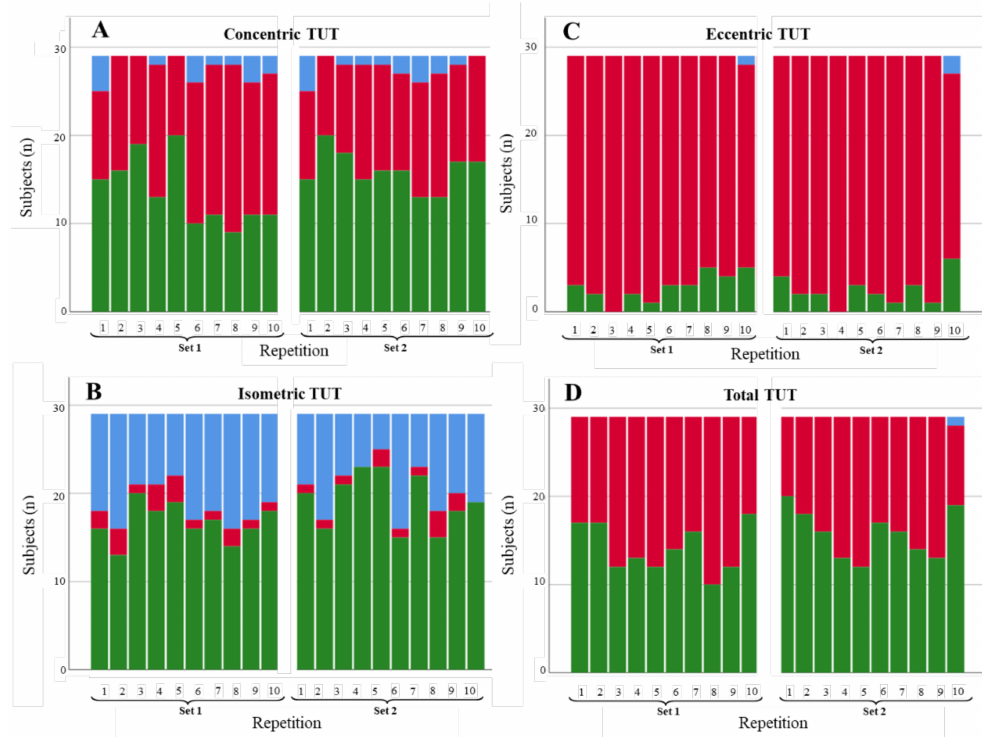
Figure 8. Degree of compliance of the TUTs for the restricted extension ROM scenario by contraction phase: ( A ) concentric, ( B ) isometric, ( C ) eccentric, and ( D ) total. TUTs: in range = green; performed in less time than expected = blue; performed in more time than expected = red.